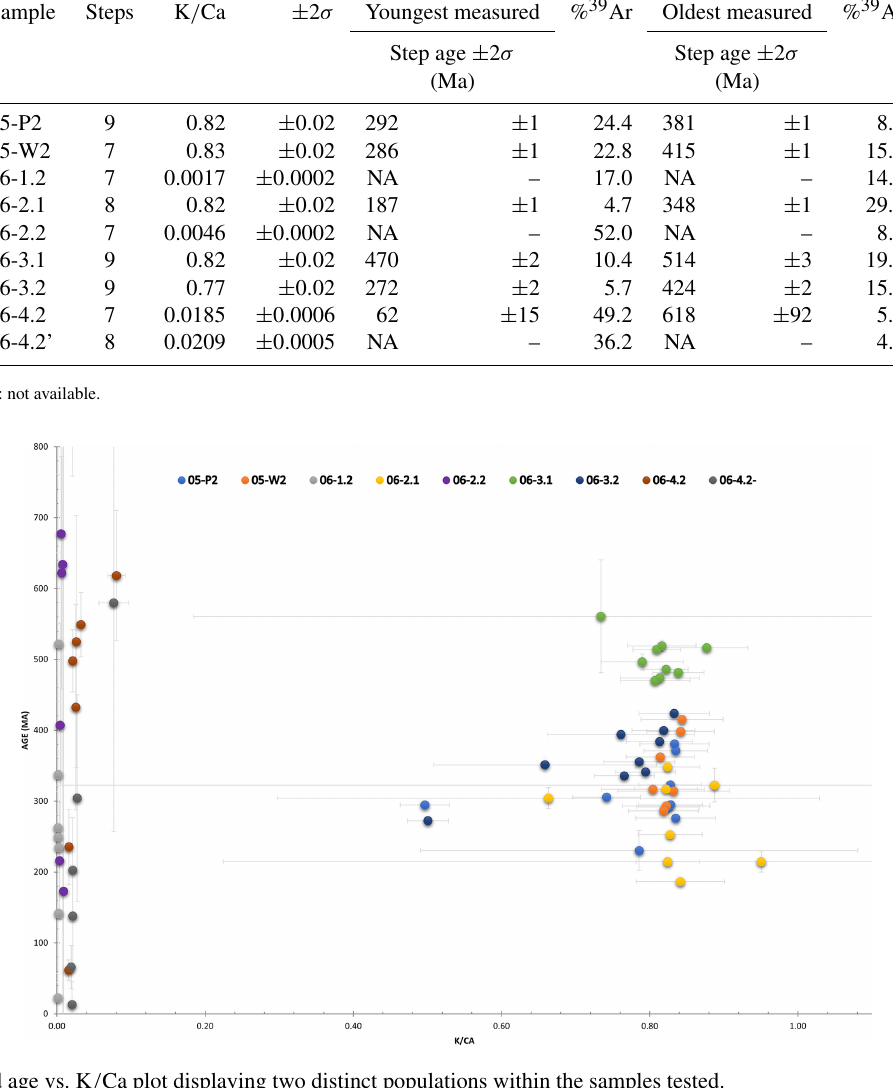
Plots of stacked, measured age and the K / Ca spectrum are presented below, with Fig. 5 showing samples with relatively high K / Ca values and Fig. 6 showing relatively low K / Ca values. All five plots in Fig. 5 show a stepped diffusion- like profile of increasing age with cumulative 39 Ar released rather than an idealised plateau. The initial and final steps in the measured age plots for 05-P2, 05-W2, and 06-3.1 (Fig. 5a, b, and d) converge around similar ages representing the youngest and oldest significant ages for their respective samples. This also occurs with plots for 06-2.1 and 06-3.2; however, the errors associated with these steps are high and as a result divert from the stepped diffusion profile at